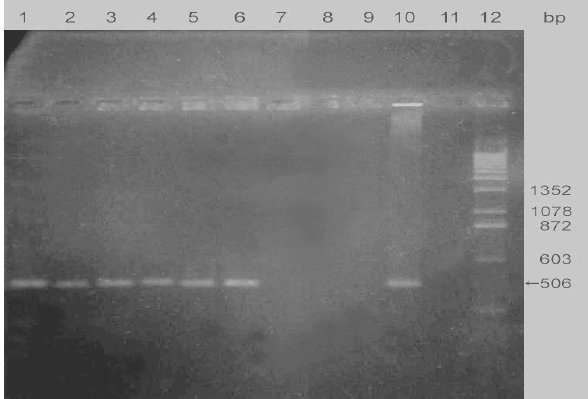
Fig. 4. – Polymerase chain reaction (PCR) products obtained after 35 amplification cycles with total DNA of Lutzomyia spp and controls: Lanes 1-6: L. spinicrassa ; Lanes 7-9: negative samples; Lane 10: Le. braziliensis LTB300; Lane 11: negative control; Lane 12: molecular size